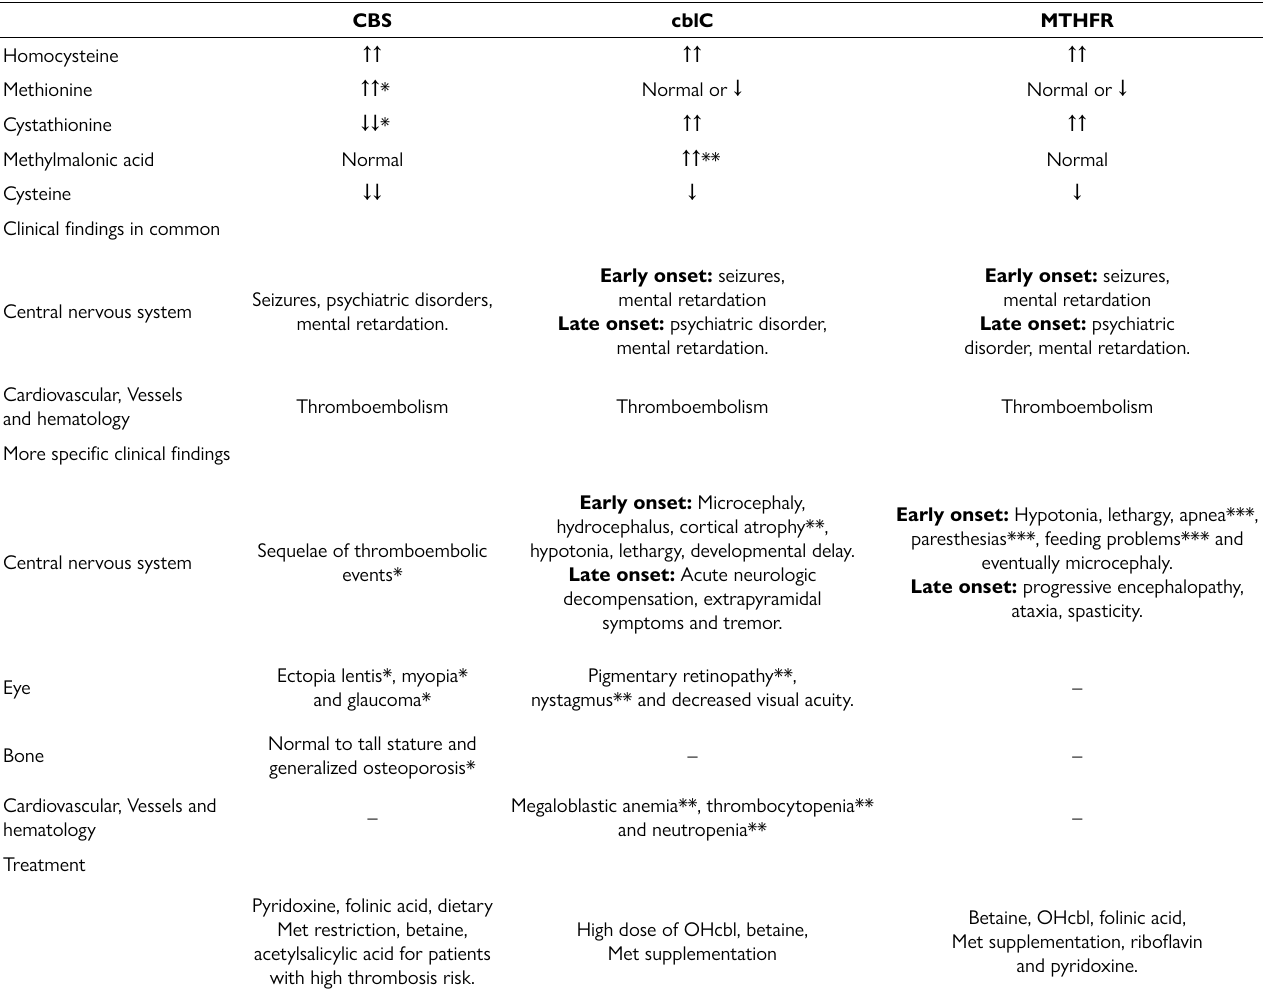
Table 2. Biochemical presentation and clinical manifestation of non-treated homocystinuria disorders due to CBS, cblC and MTHFR